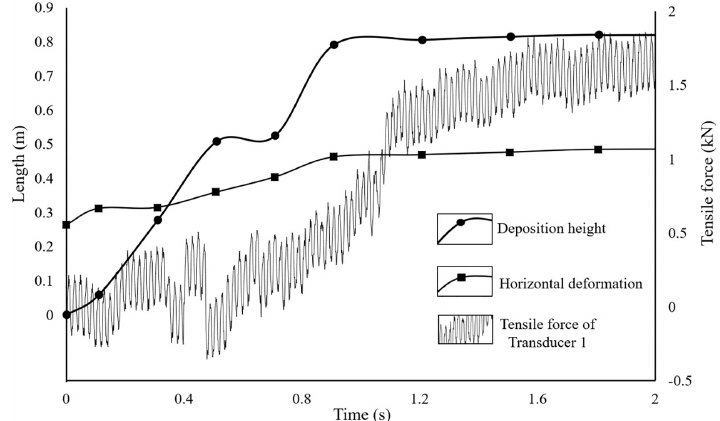
Figure 6. Relation between the deposition height of the granular flow, horizontal deformation of the flexible barrier, and tensile force of transducer 1 vs. time in test